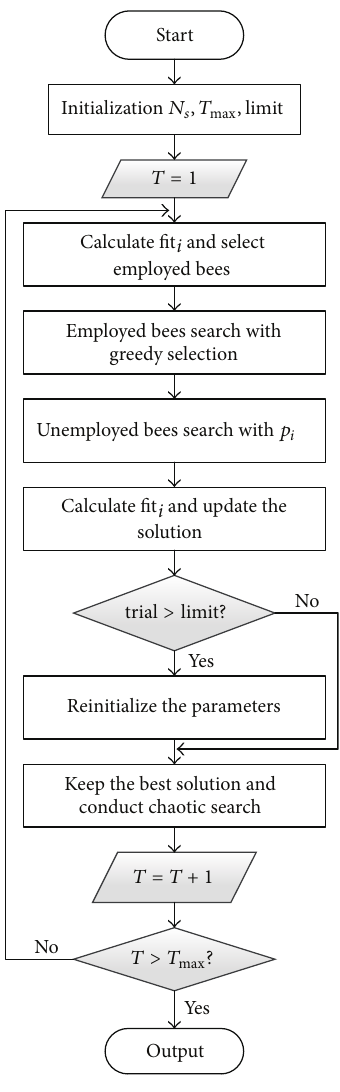
Figure 3: The procedure of CABC method.